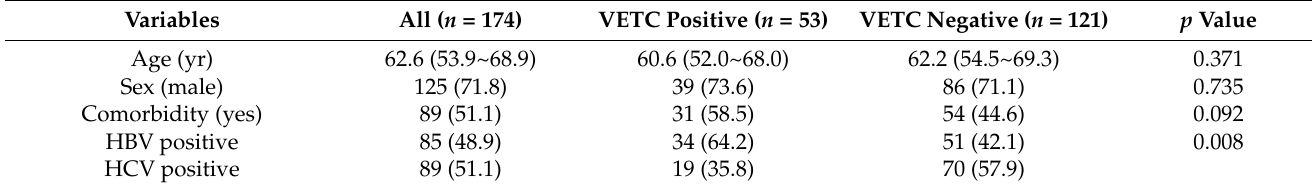
Table 1. Demographic data and clinical correlations with VETC classification for HCC patients after partial